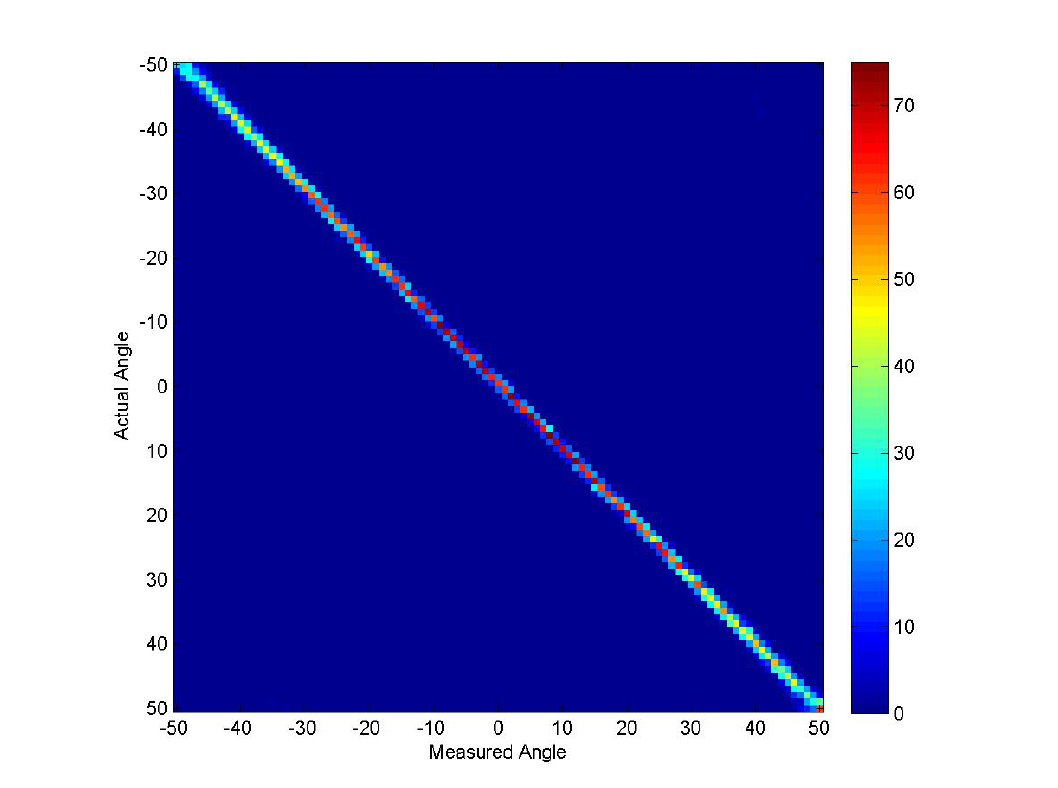
Figure 16. Ambiguity plot for Experiment 5 (13-dB threshold).